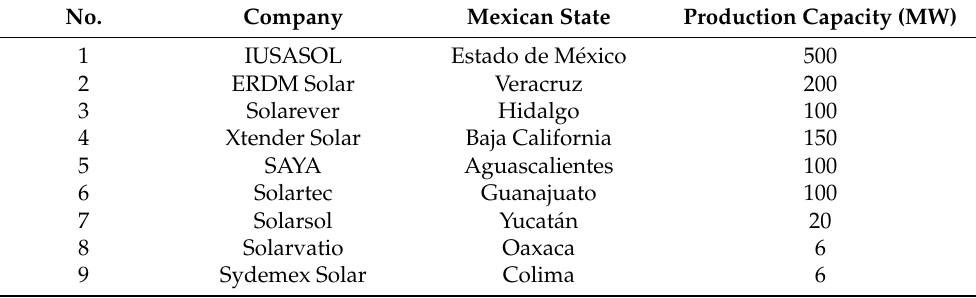
Table 2. PV module assembly companies in Mexico in 2018.